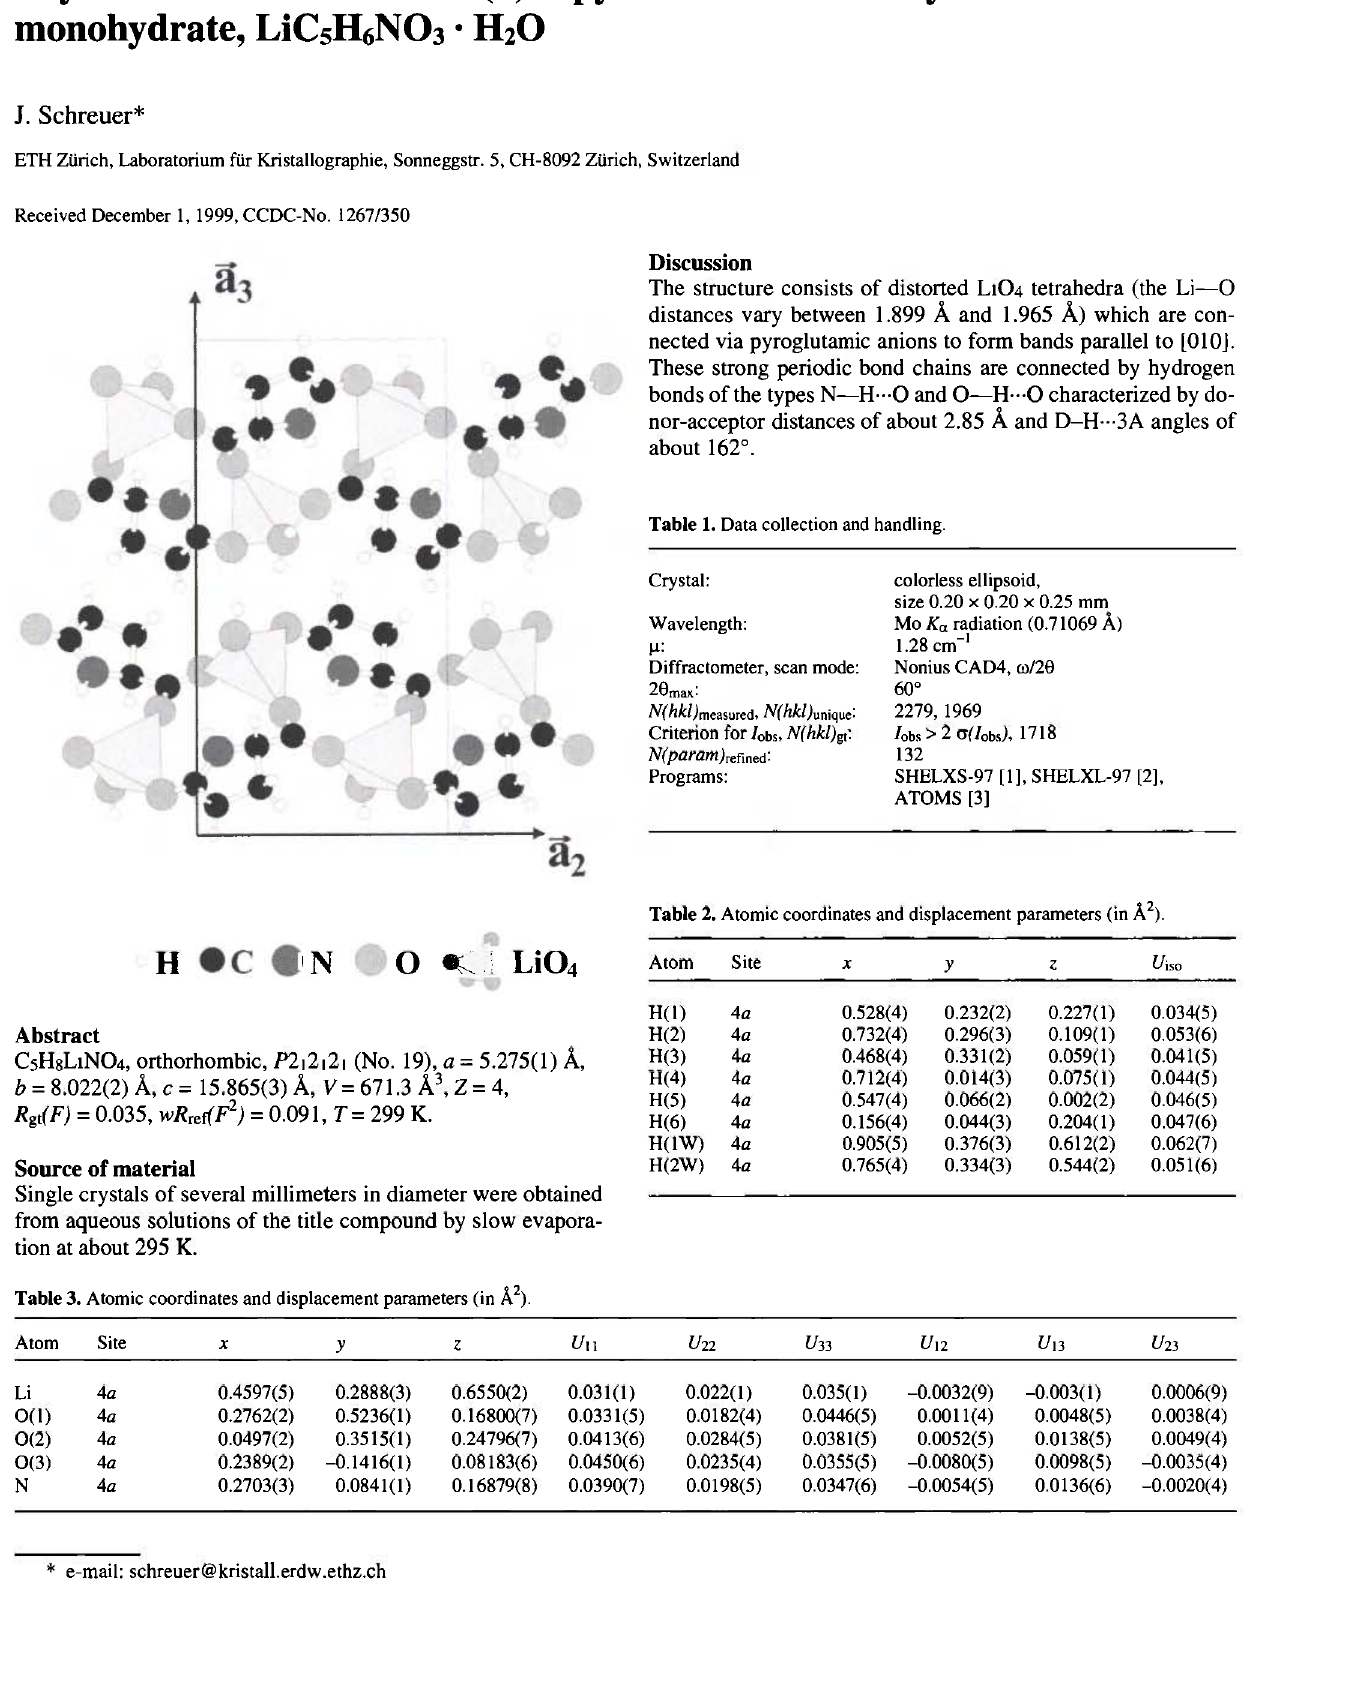
Table 1. Data collection and handling.